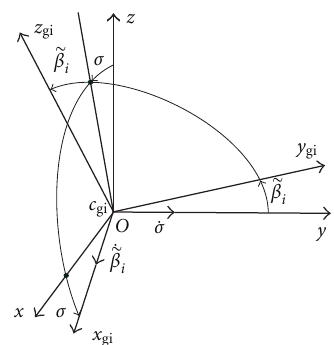
Figure 7: Sequence of rotations for GD axes.